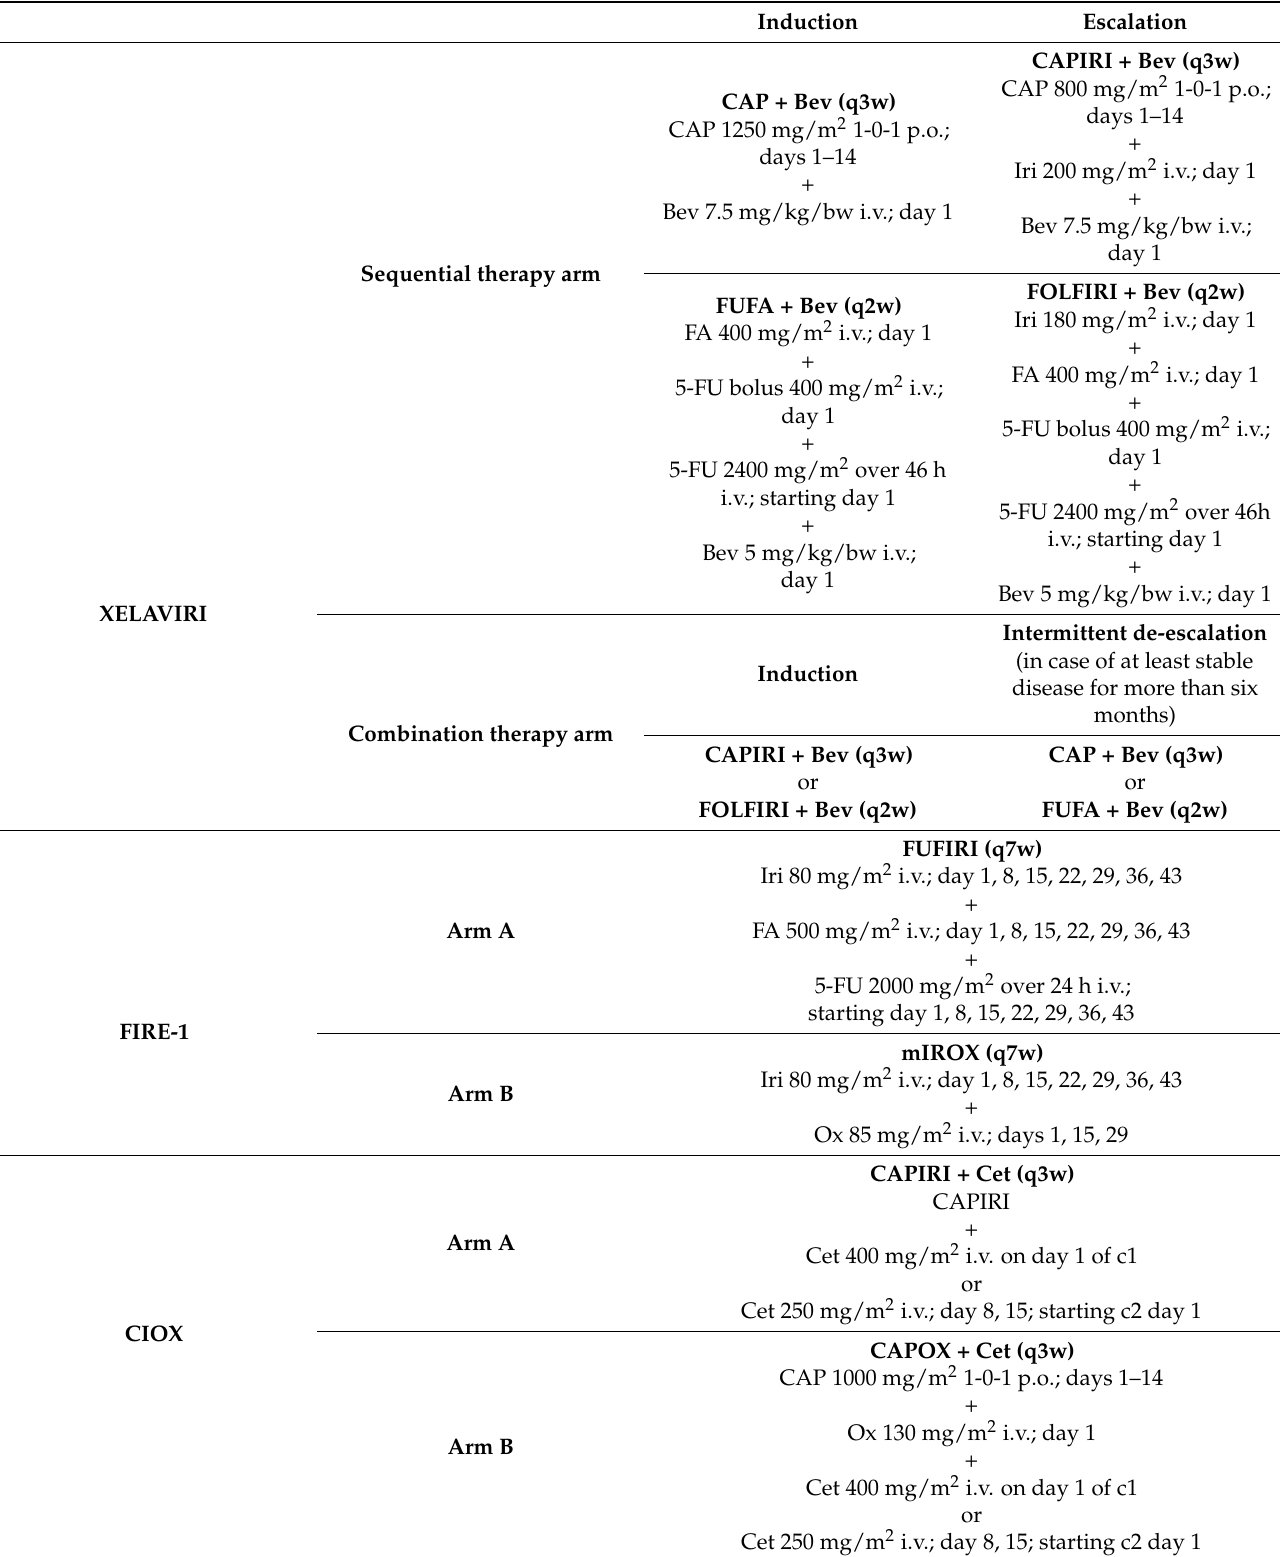
Table 2. Treatments protocols according to each